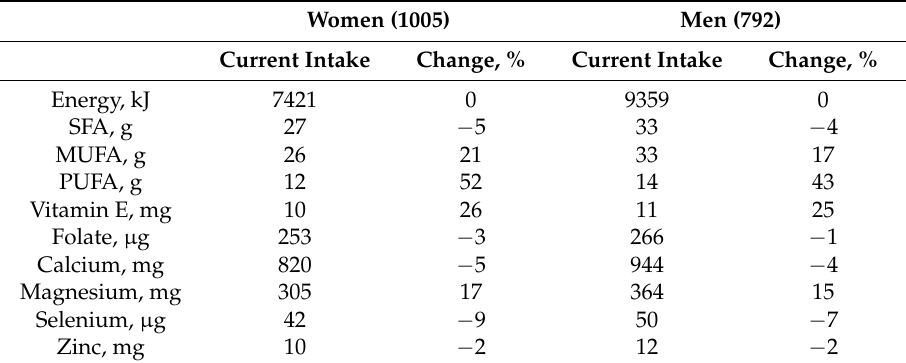
Table A1. Changes in daily nutrient intakes in a scenario where the energy content of the PREDIMED nut mix 817 kJ replaces the corresponding amount of the average diet in men and women from a nation-wide dietary survey